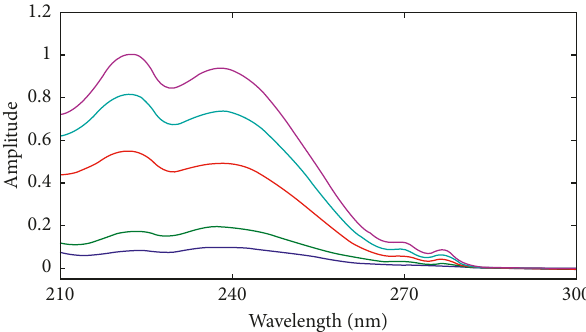
Figure 7: The zero-order absorption spectra of aclidinium (5–40 µ g/mL) obtained by the proposed ratio subtraction method for the analysis of laboratory-prepared mixtures with formoterol (5–10 µ g/mL) after multiplication by the